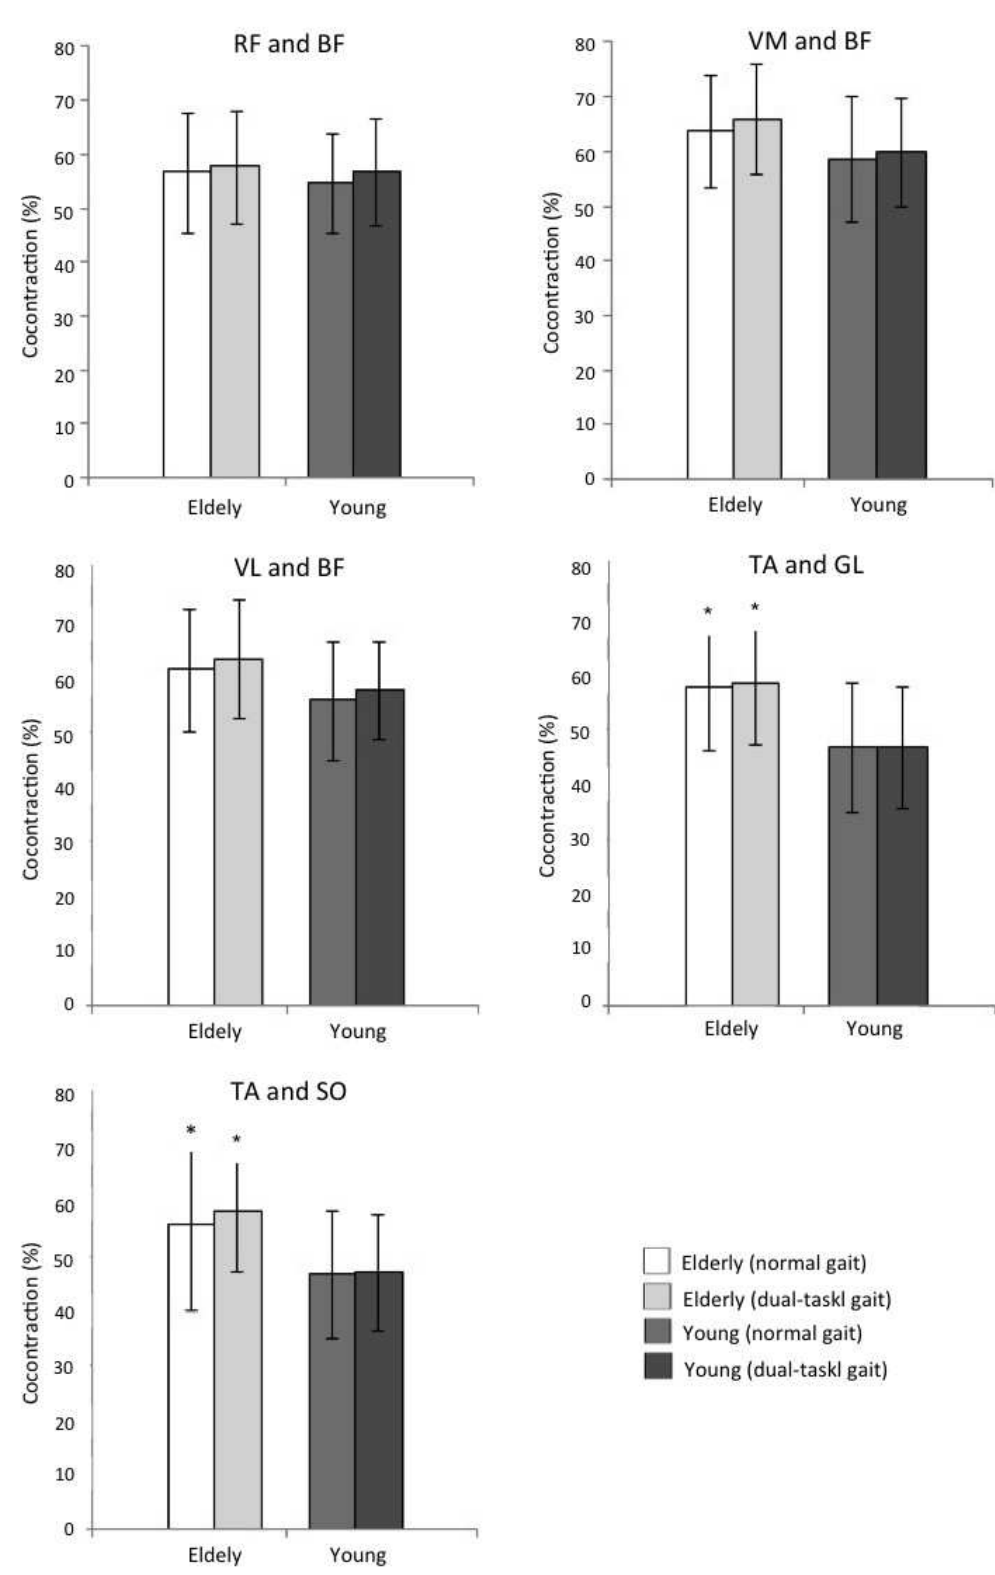
623Figure 2. Percent of coactivation between rectus femoris (RF) and biceps femoris (BF), vastus lateralis (VL) and BF, vastus medialis (VM) and BF, tibialis anterior (TA) and gastrocnemius lateralis (GL), TA and soleus (SO) muscles in both gait conditions.* p <0.05 between older and younger